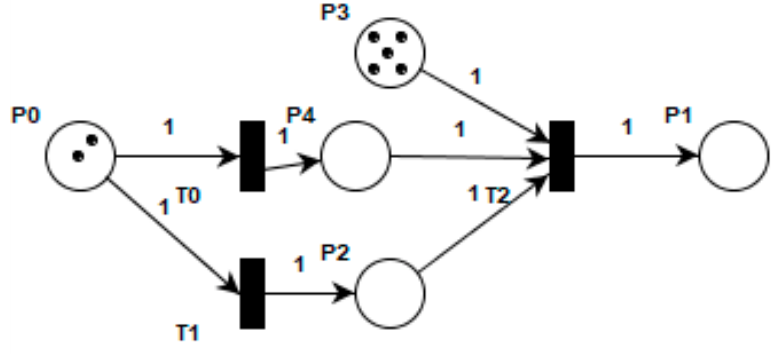
Figure 2. Example of a basic Petri net.